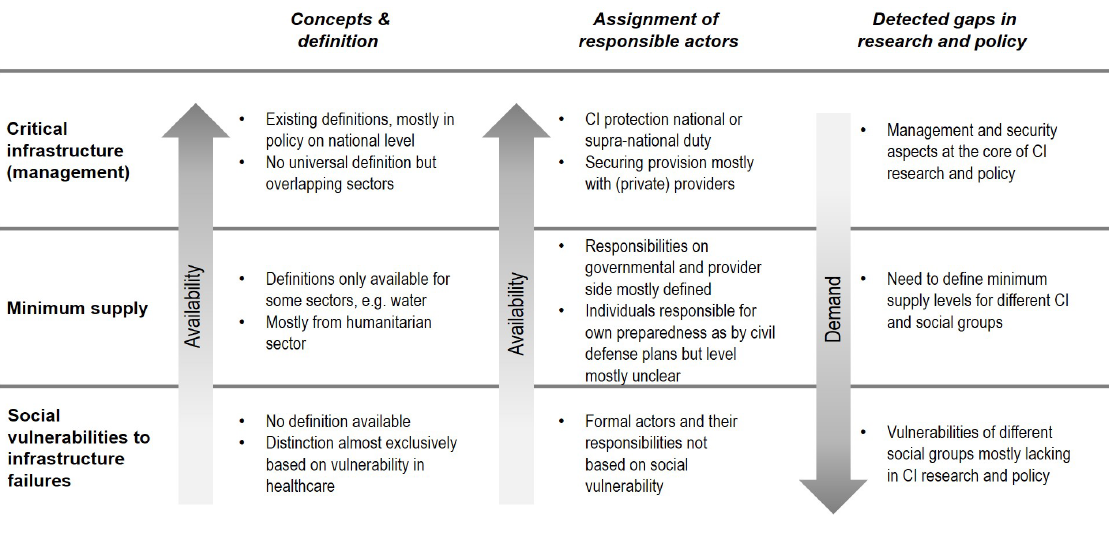
Figure 2. Summary of concepts, actors and gaps in dealing with critical infrastructure, minimum supply and social vulnerabilities.